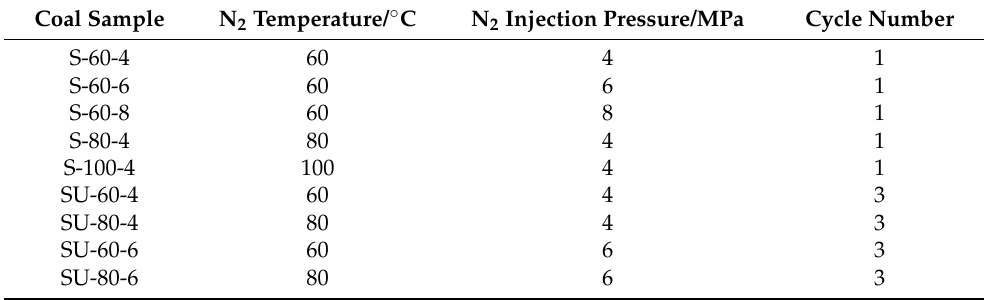
Table 2. Experimental conditions for six